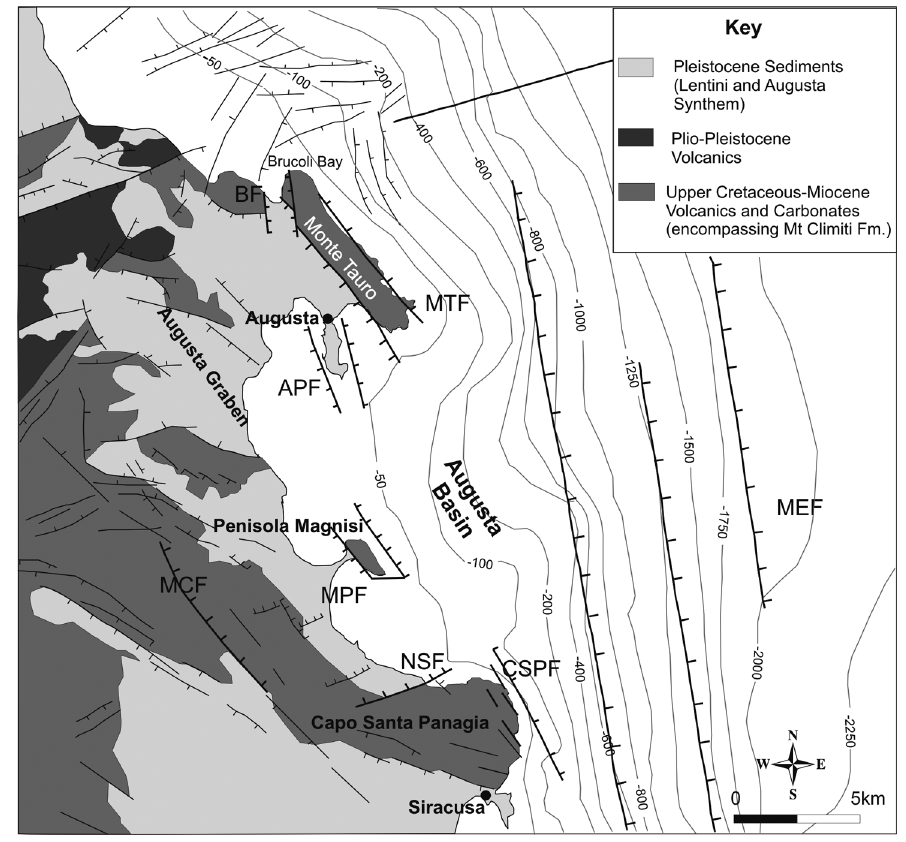
Figure 2. Geological sketch map of Augusta Graben showing the emerged Augusta Bay and the actual Augusta Basin. Structural elements are from: Ambrosetti et al. [1987], Catalano et al. [2010] and Carbone et al. [2011]; BF = Brucoli Faults; MTF = Mt Tauro Faults; APF = Augusta Peninsula Faults; MCF = Mt Climiti Fault; MPF = Magnisi Peninsula Faults; NSF = North Siracusa Fault; CSPF= Capo Santa Panagia Faults; MEF = Malta Escarpment